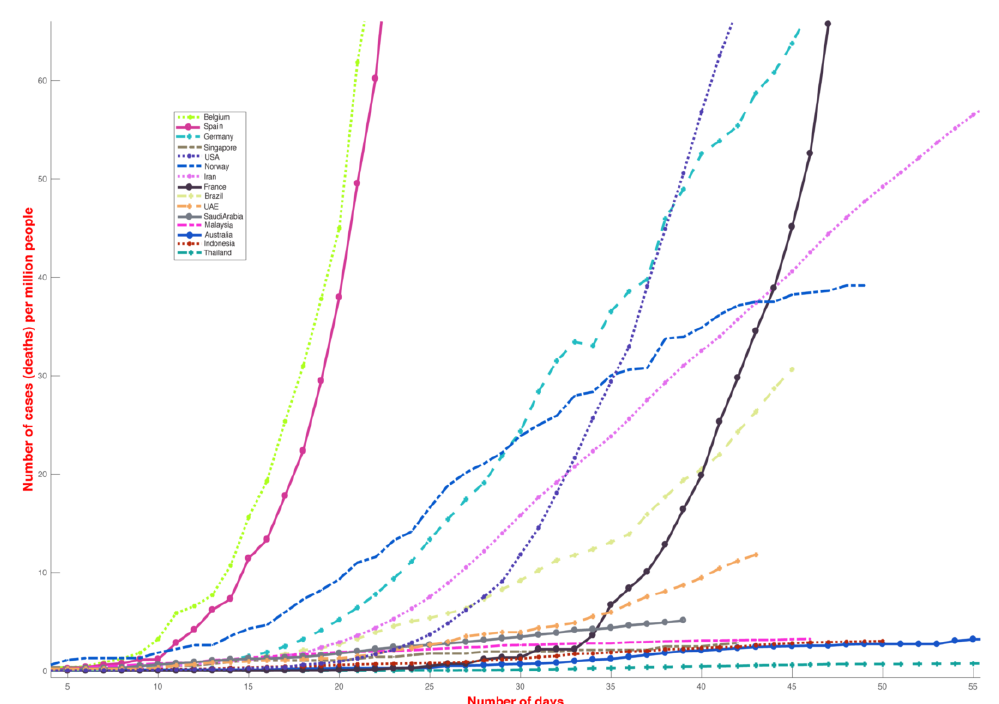
Figure 3. Cumulative death rate curve of COVID-19 deaths for select different countries (until 1 May 2020). The figure shows the total number of deaths (normalized by the population of the country). Different regions and states clearly follow different curves of death rate. The y -axis has been capped at 60 cases per 1,000,000 population.